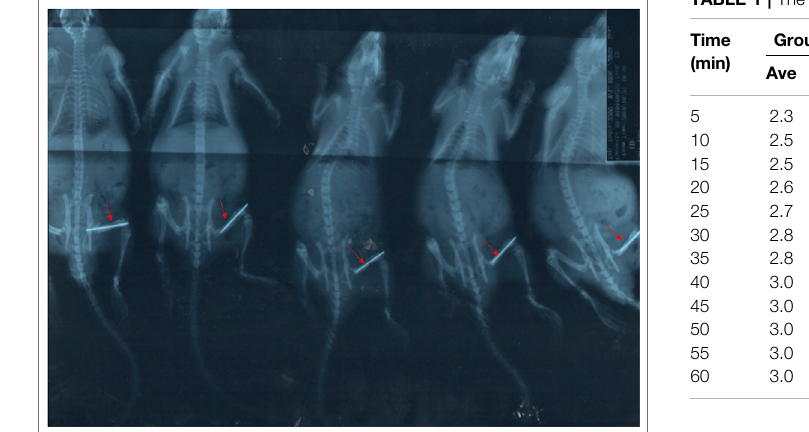
FIGURE 1 | X-ray of the closed femoral shaft fracture Model.